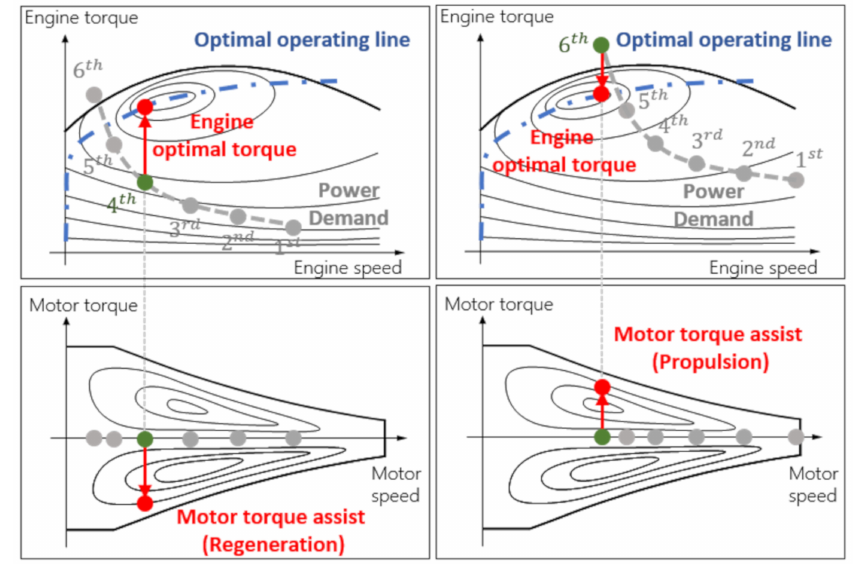
Figure 18. Concept of Power Source Control Strategy.